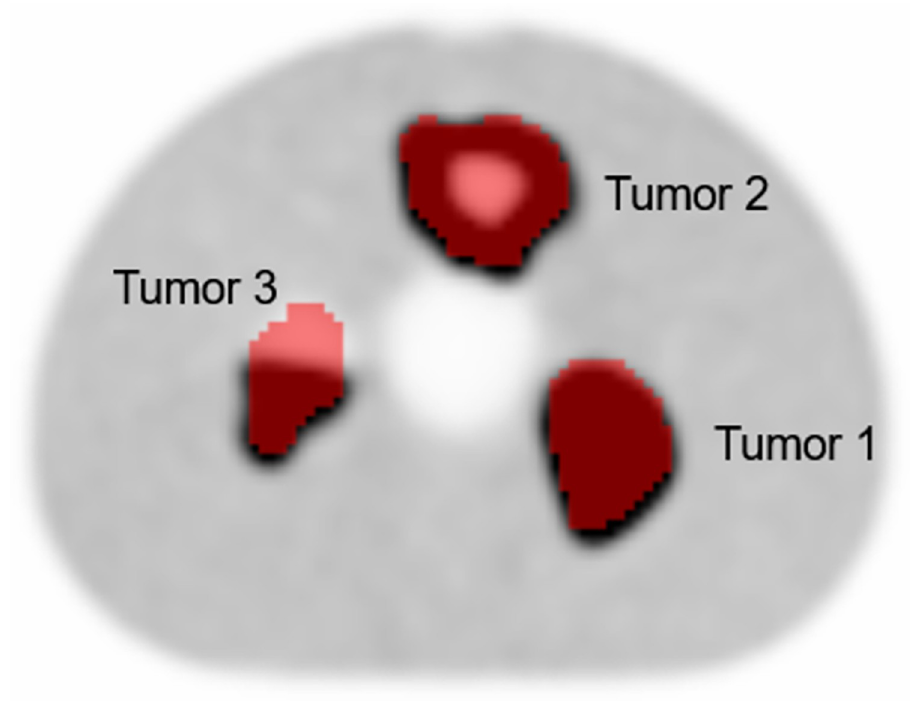
Fig 1. PET image showing phantom with 3D printed inserts reflecting heterogeneous tracer uptake.